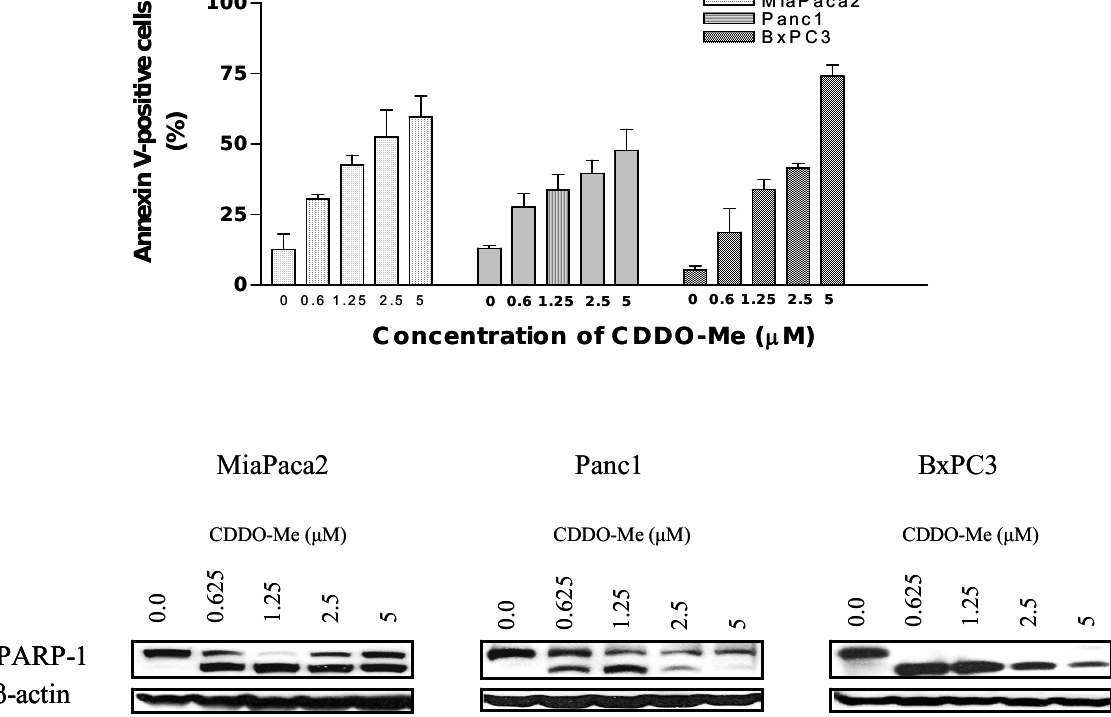
PARP-1. ( A ) MiaPaca2, Panc1 and BxPC3 cells were treated with CDDO-Me